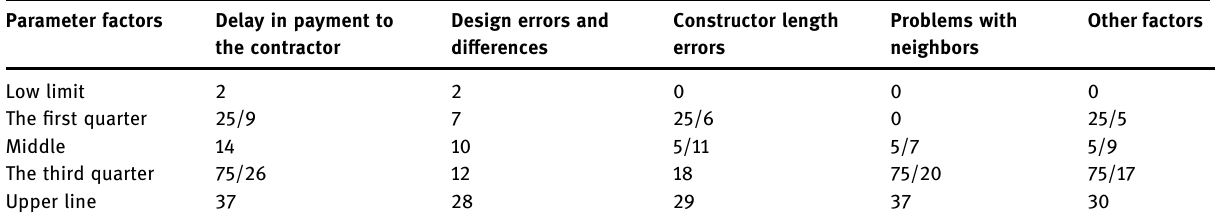
Table 2: Comparison of delay due to fi ve factors with line chart Parameter